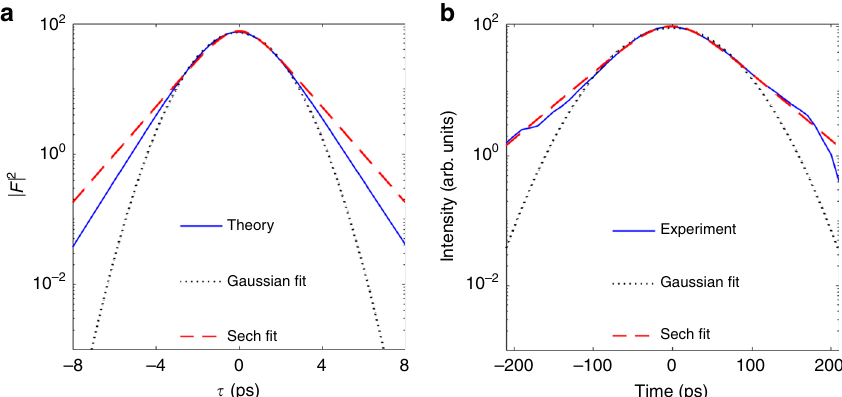
Fig. 5 Shape of the most symmetric pulses. The intensity of the most symmetric theoretical ( a ) and experimental ( b ) pulse is depicted in logarithmic scale together with Gaussian and hyperbolic-secant fi ts. It is evident that pulse tails deviate substantially from the Gaussian shape predicted by Haus theory, exhibiting a smoother decay. The pulses shown here correspond respectively to those in Fig.